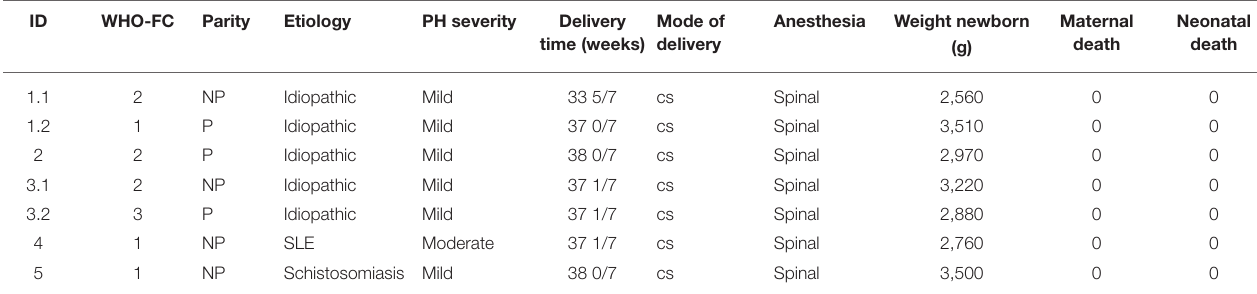
TABLE 5 | Characteristics and outcomes of the